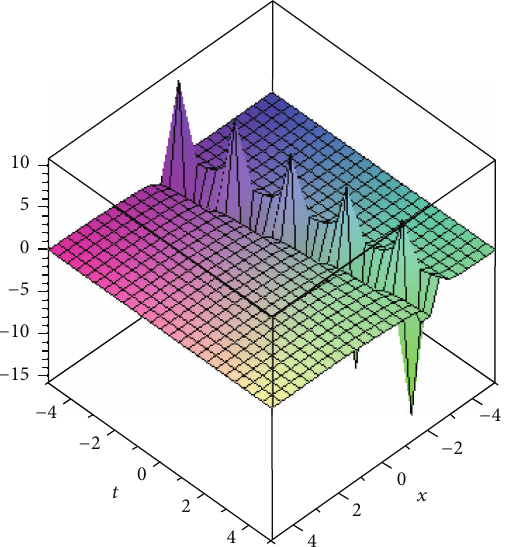
Figure 5: The plot of solution (39) with 𝑎 = 𝑛 = 𝜇 = 2 , 𝑏 = 𝑅 = 1 . that the solution (39) is a bell-kink shaped soliton solution;